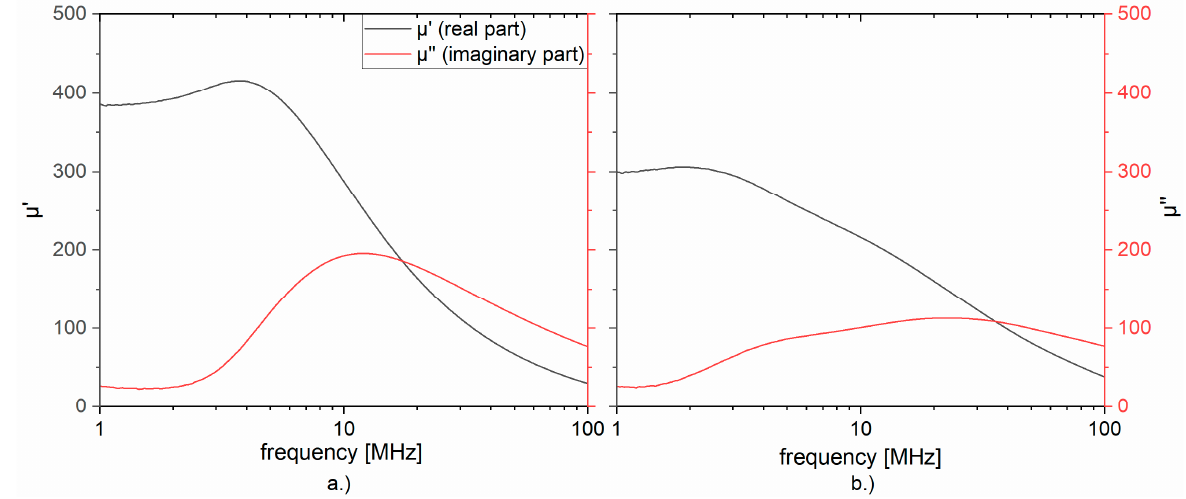
Figure 8. Permeability spectra vs. frequency for ( a ) z = 0.06 sintered at 950 ◦ C with fine-grained microstructure and ( b ) z = 0.06 sintered at 1100 ◦ C with large grains .